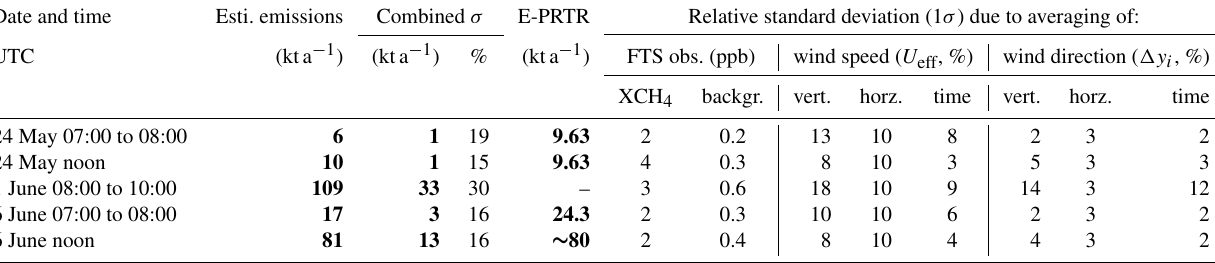
Table 2. Overview of successful plume transects along with relative standard deviations of the primary sources of uncertainty. Error estima- tion procedures are explained in the main text. Bold numbers represent estimated emissions and errors together with the respective E-PRTR 2014 entries in the fifth column, which are the mine-wise reported values distributed evenly to every single listed shaft of each mine. Several upwind sources do not allow accurate source attribution on 1 June, and hence no E-PRTR estimate is reported. E-PRTR CH 4 sources con- tributing to the observations of the noon transect on 6 June amount to roughly 80kta − 1 , if only considering mining ventilation shafts in the near surroundings (20km radius). However, far upwind (60km) ventilation shafts can influence the measurements although all mines located in the direct wind direction are listed with 0kta − 1 and reach 13kta − 1 somewhat north of the mean wind